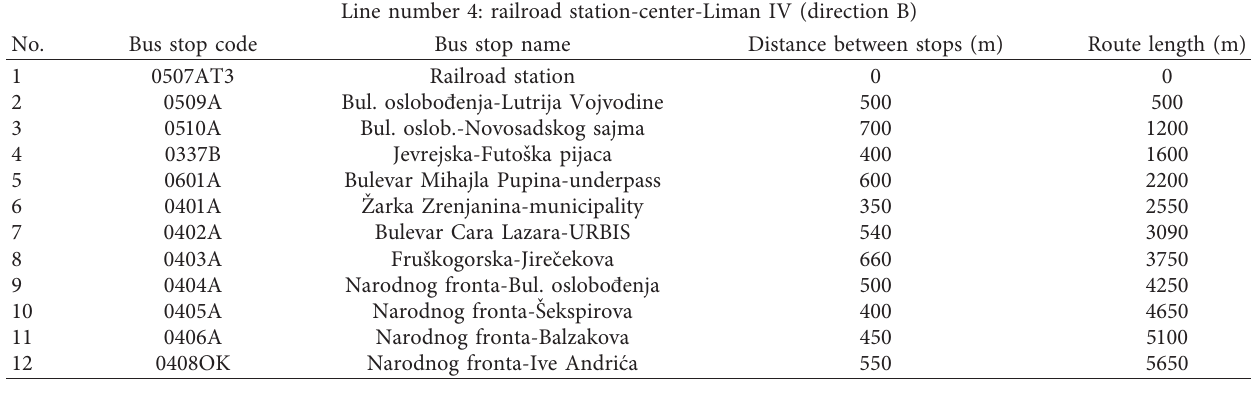
Table 2: Characteristics of the stops of line 4, direction B.